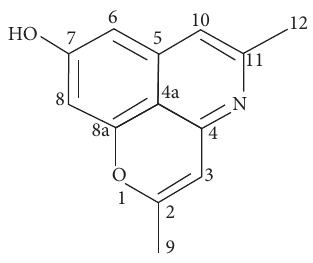
Figure 1: Structure of Cassiarin